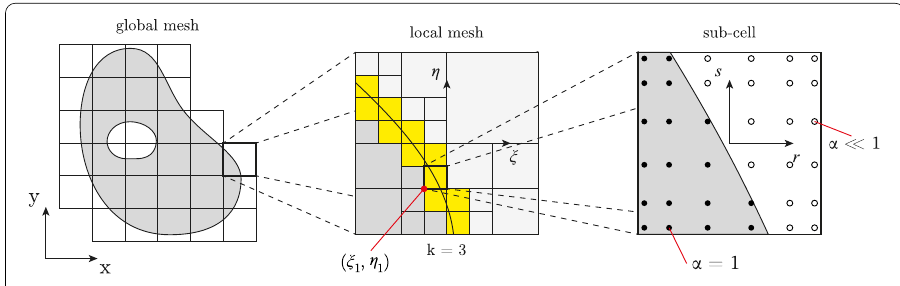
Fig. 8 Illustration of the basic idea of the AIS: The numerical integration of each sub-cells is executed in the local r - s -coordinate system, where the integrand is evaluated at all IPs and the result is scaled based on the α -value obtained from Eq.